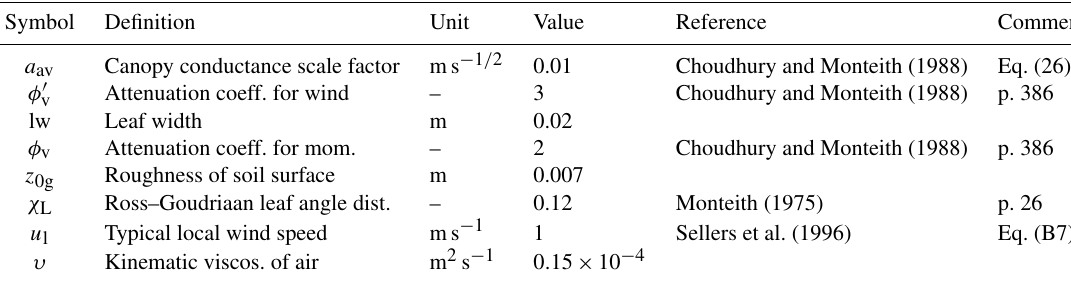
Table 3. Surface vegetation canopy turbulence parameters that are constant. Symbol Definition Unit Value Reference